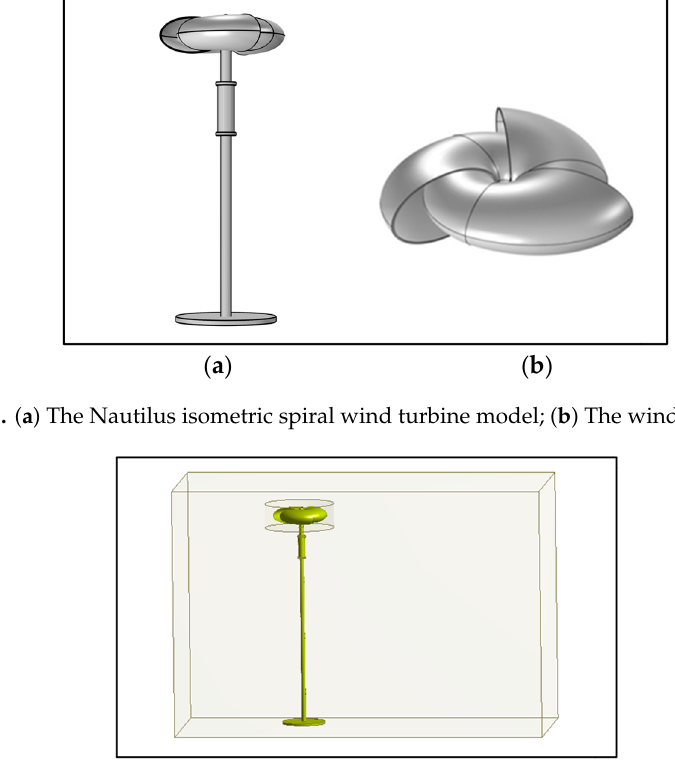
Figure 2. The static domain and rotating domain of the wind turbines.